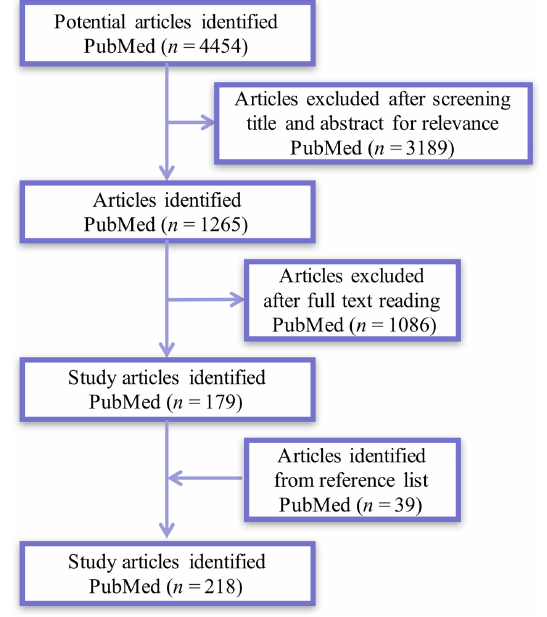
Figure 1. Flowchart of article screening.